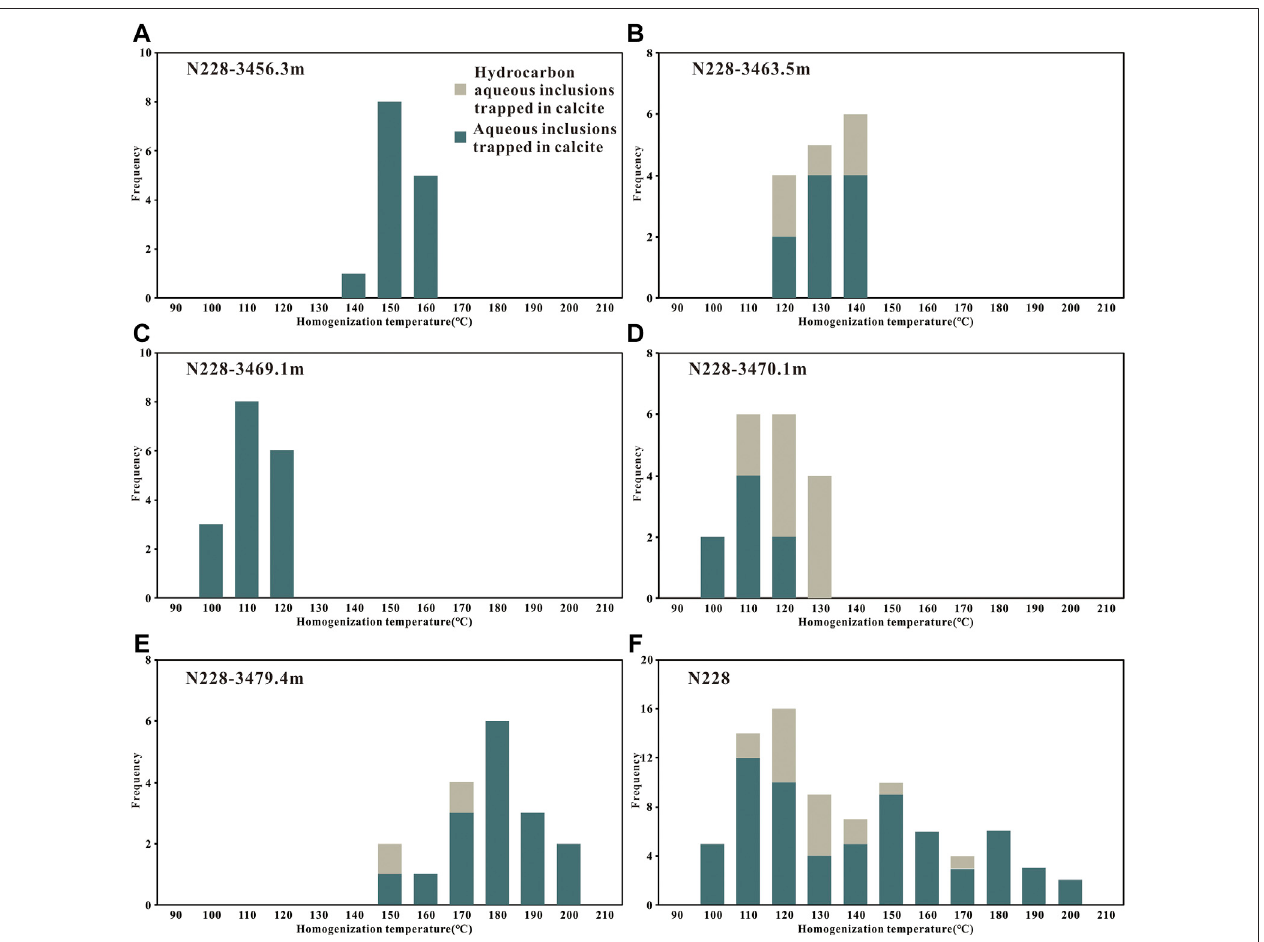
FIGURE 6 | Th histogram of well N228 in the Changning area, southern Sichuan Basin. (A) , (B) , (C) , (D) , (E) , and (F) Th histograms of samples N228-3456.3 m, N228-3463.5 m, N228-3469.1 m, N228-3470.1 m, N228-3479.4 m, and summary of all samples.